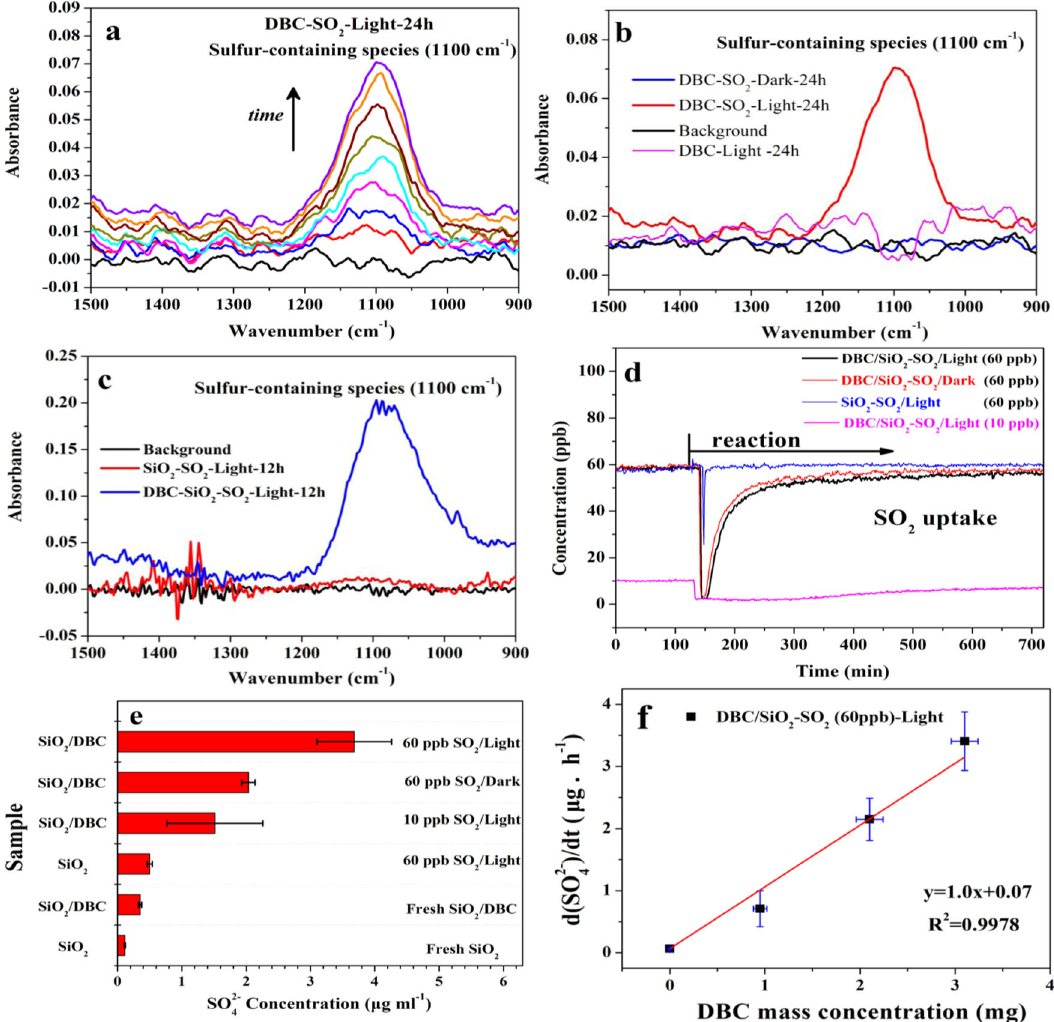
Fig. 1 | Formation and yield of sulfur-containing products on DBC surface. In- situ DRIFTS spectra of DBC exposed to 10ppm SO 2 for 24h under irradiation ( a ); comparisonofsulfur-containingspeciesformationunderlightanddarkconditions ( b ); comparison of sulfur-containing species formation in the absence and